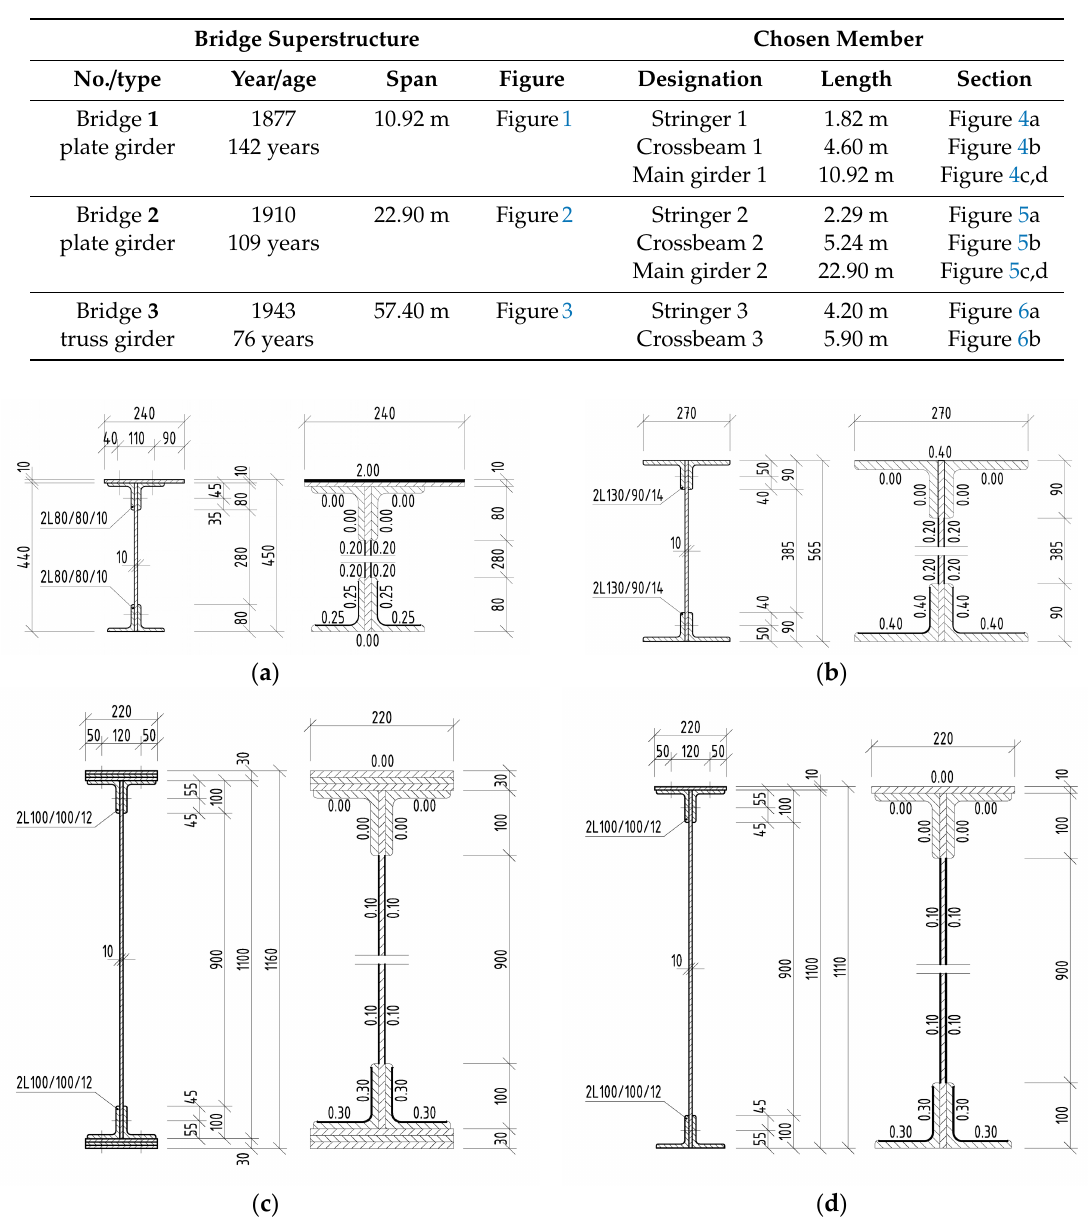
Table 1. Basic data and designations of the chosen bridges and their members.